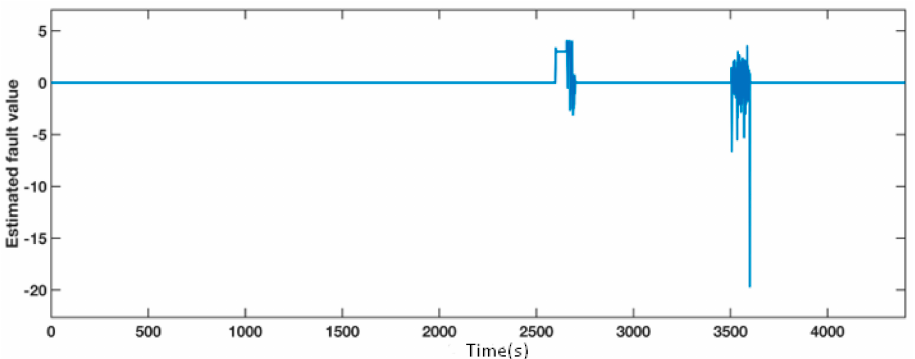
Figure 7. Estimated fault value from adaptive observer designed for the pitch angle 3.